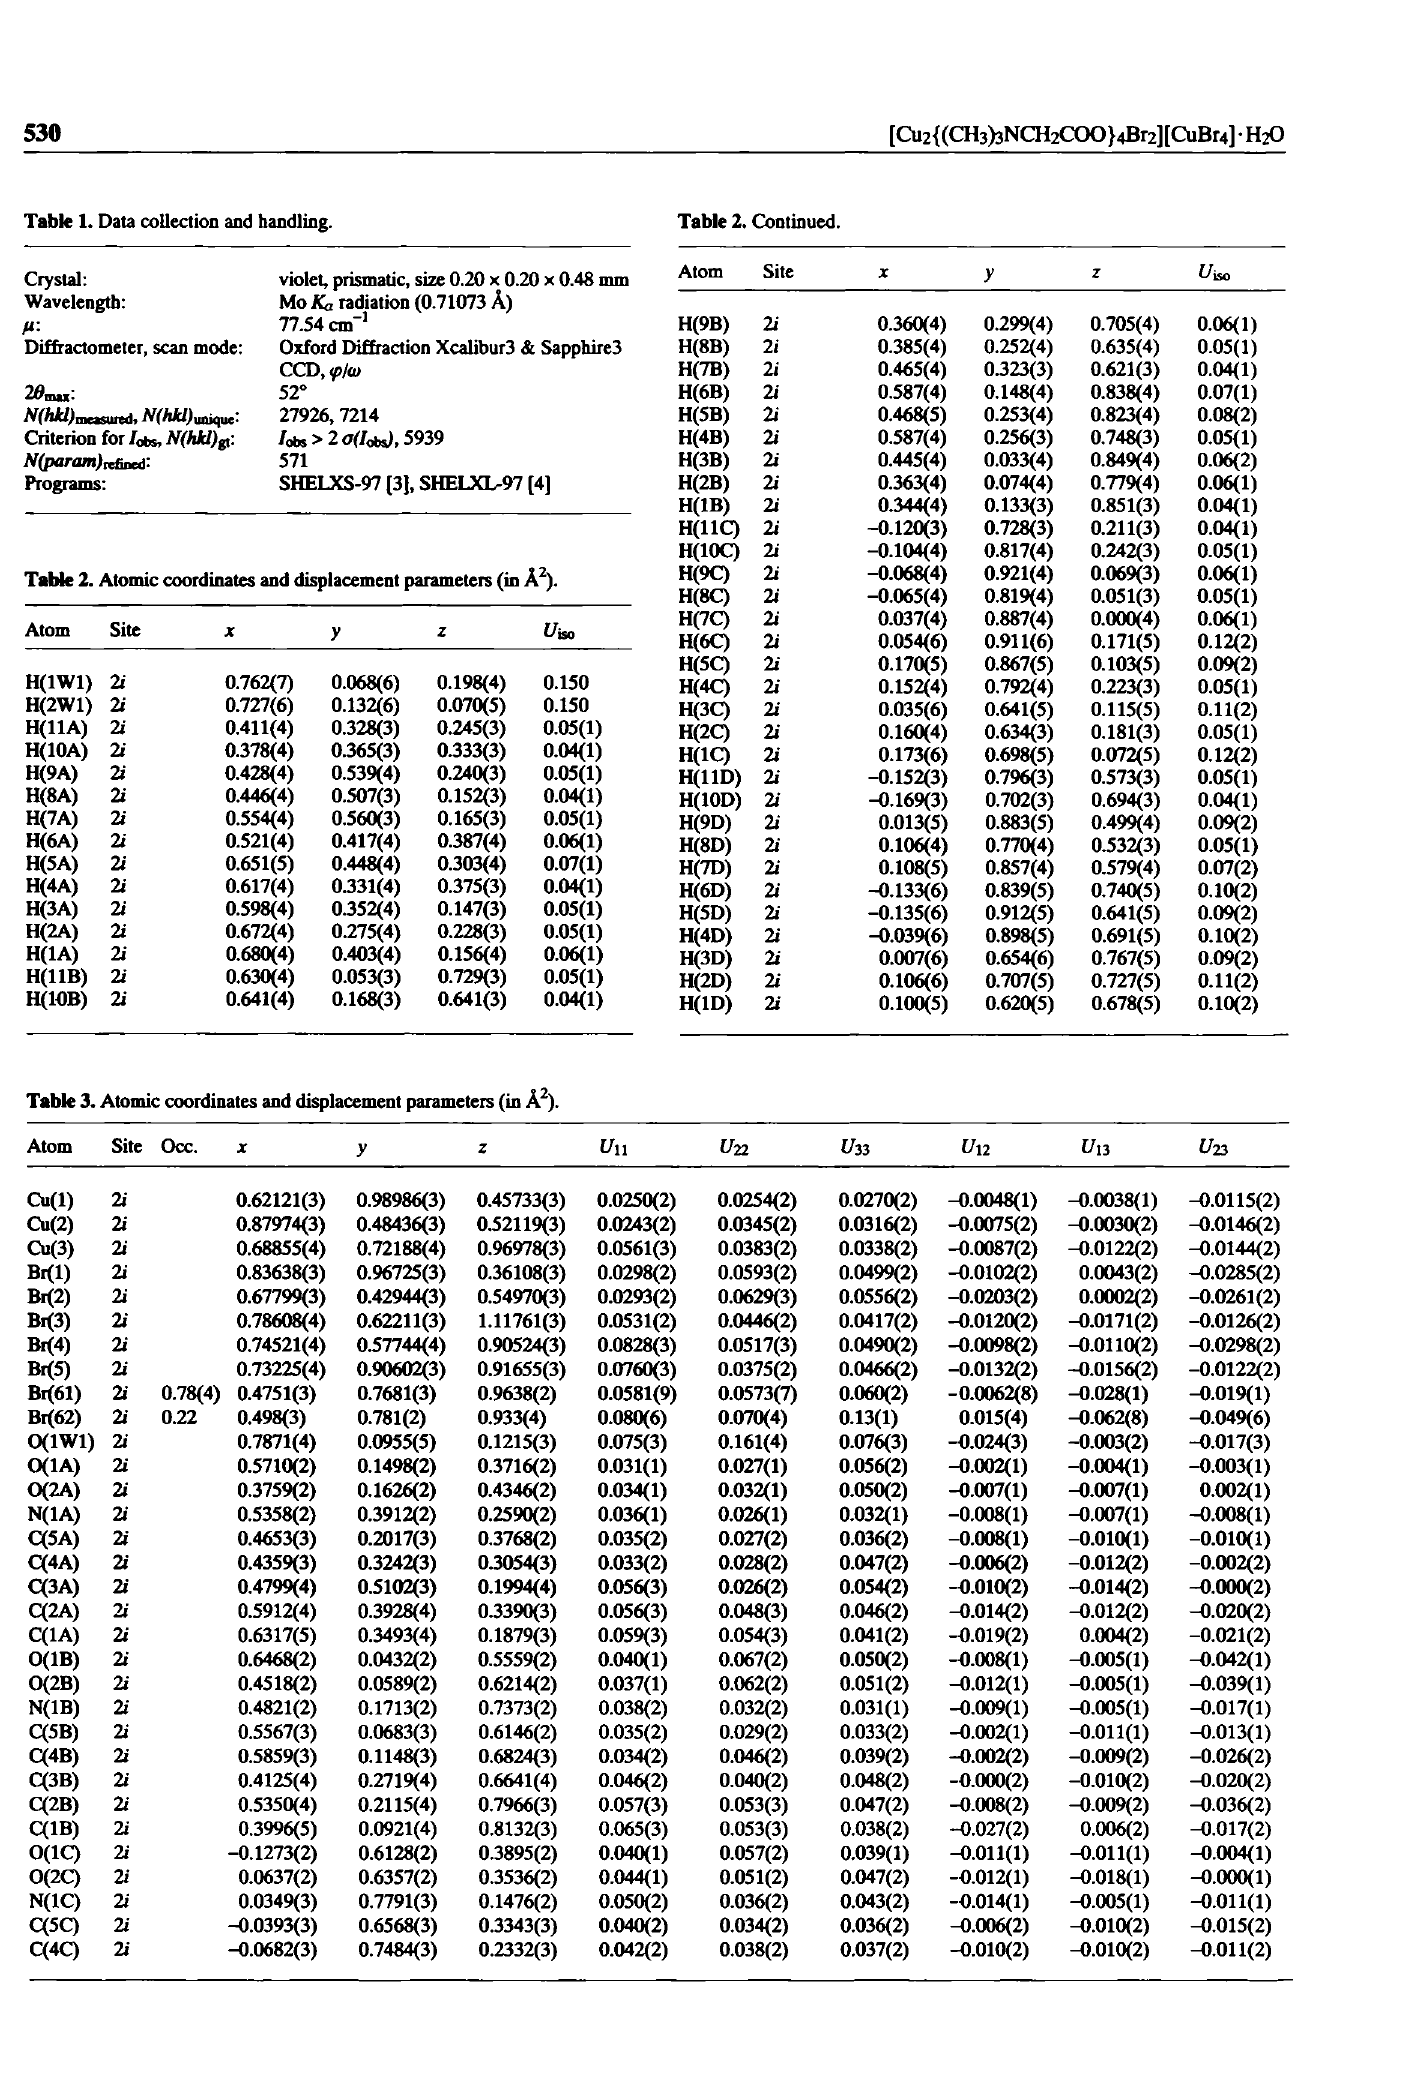
Table 2. Atomic coordinates and displacement parameters (in A 2 ).